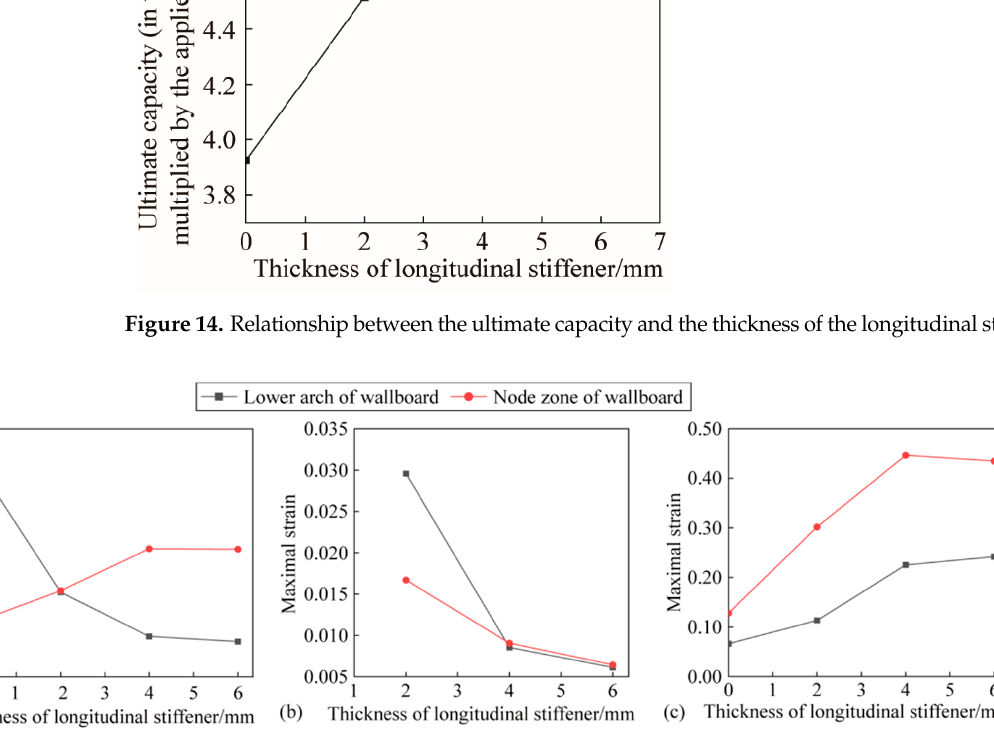
Figure 15. Maximal strain vs. thickness of the longitudinal stiffening rib in the juncture node zone and lower arch of ( a ) web, ( b ) longitudinal stiffening rib, and ( c ) diaphragm. The ultimate capacity of the model increases with the thickness, as displayed in Figure 13. On the contrary, with an increase in thickness, the plastic strain in the web shows different tendencies in the juncture node zone and the lower arch, as shown in Figure